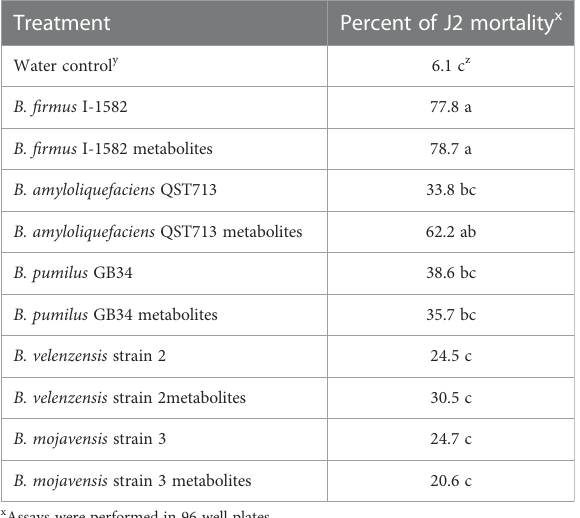
TABLE 3 In vitro assay to determine the percent mortality of Meloidogyne incognita J2s 48 hours after exposure to fi ve Bacillus